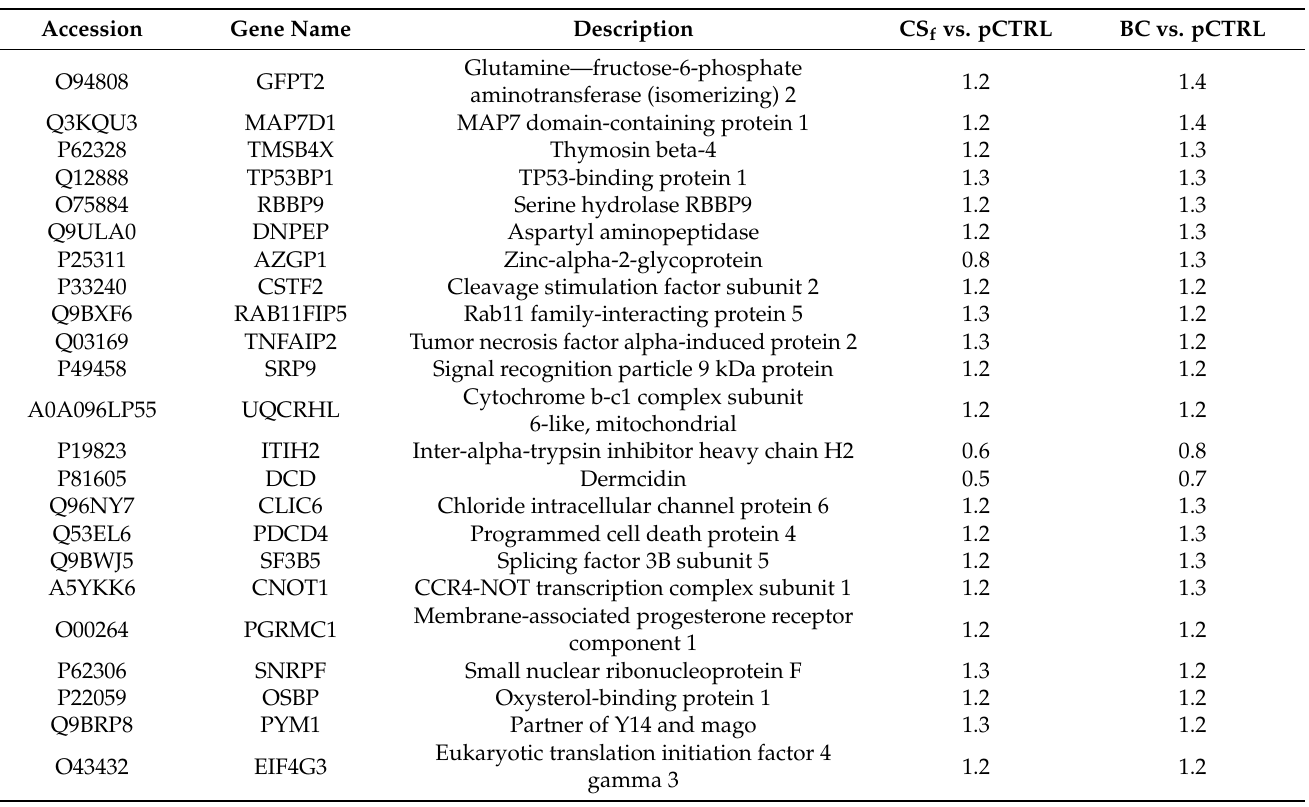
Table 2. Proteins differentially expressed (0.8 ≥ FC ≥ 1.2) in both CS f - and BC-treated vs. pCTRL synoviocytes identified by high-resolution LC-MS/MS.